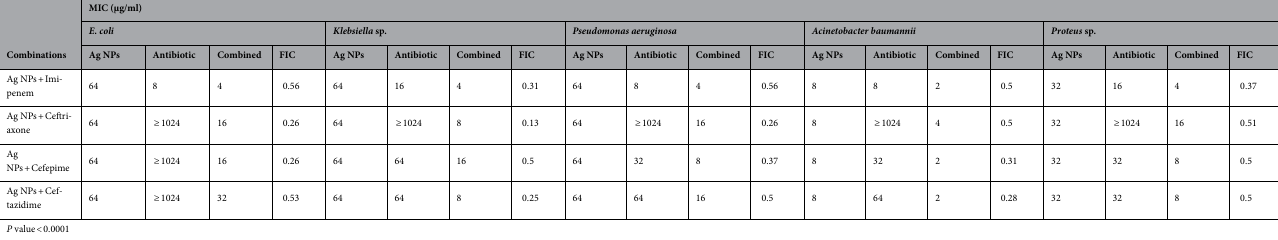
Table 5. Determination of FIC and combined effect of antibiotics and Ag NPs on strains of CPGB. FIC: Fractional inhibitory